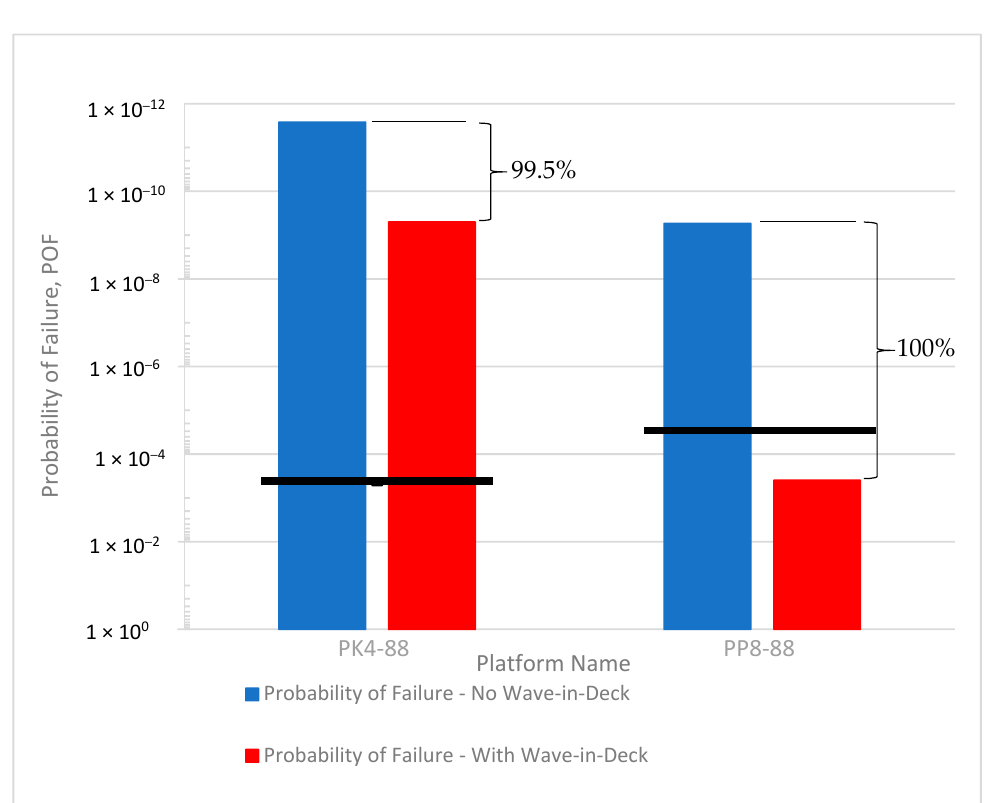
Figure 11. Comparison of probability of failure with and without inclusion of wave-in-deck load.